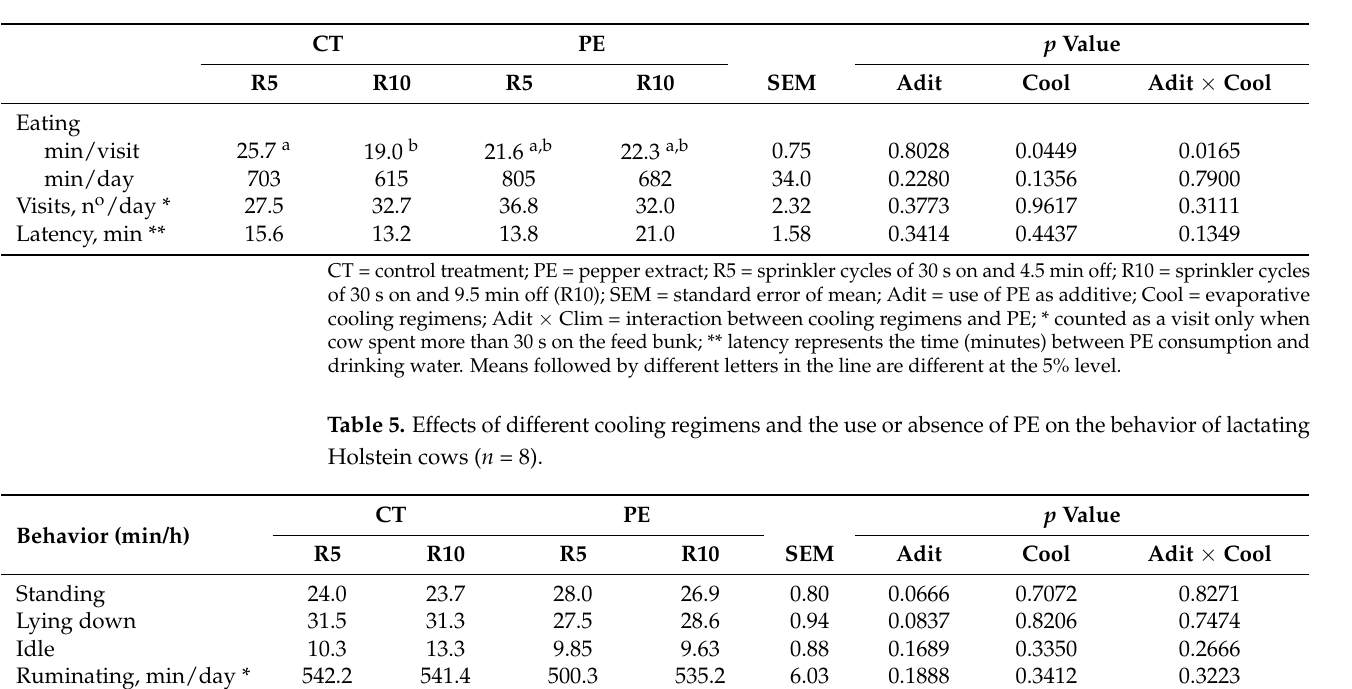
Table 4. Effects of different evaporative cooling regimens and the use or absence of PE on the feed behavior of lactating Holstein cows ( n = 8).